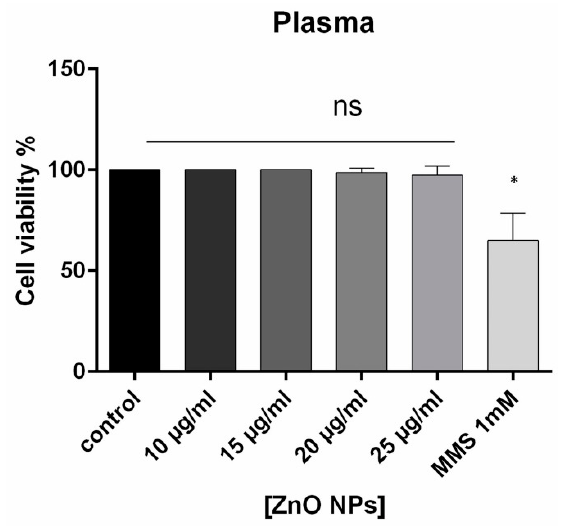
Figure 6. Cytotoxicity. The MTT assay was performed to analyze the cytotoxic effects of ZnO-NP in hMSCs cultivated in plasma. No attenuation of cell viability could not be observed after exposure to ZnO-NPs at the concentrations of 20 µg/mL as well as 25 µg/mL. Statistical analysis was performed as described above. A significant attenuation of cell viability was measured after adding of MMS. * indicates the statically significant